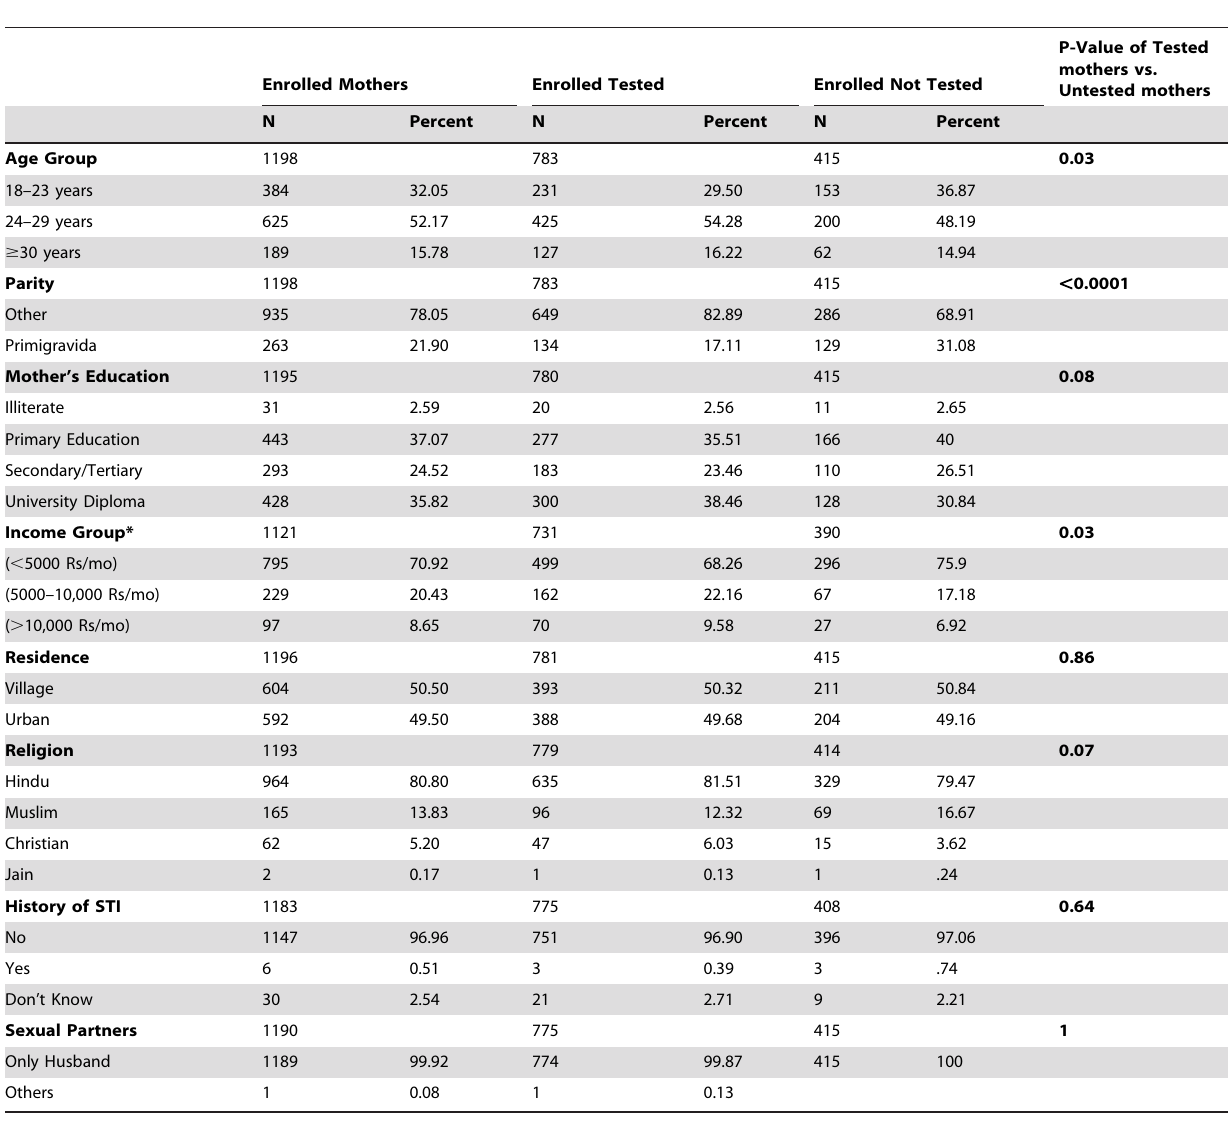
Table 2. Baseline characteristics of Enrolled Mothers, Enrolled Tested mothers, and Enrolled and not Tested.